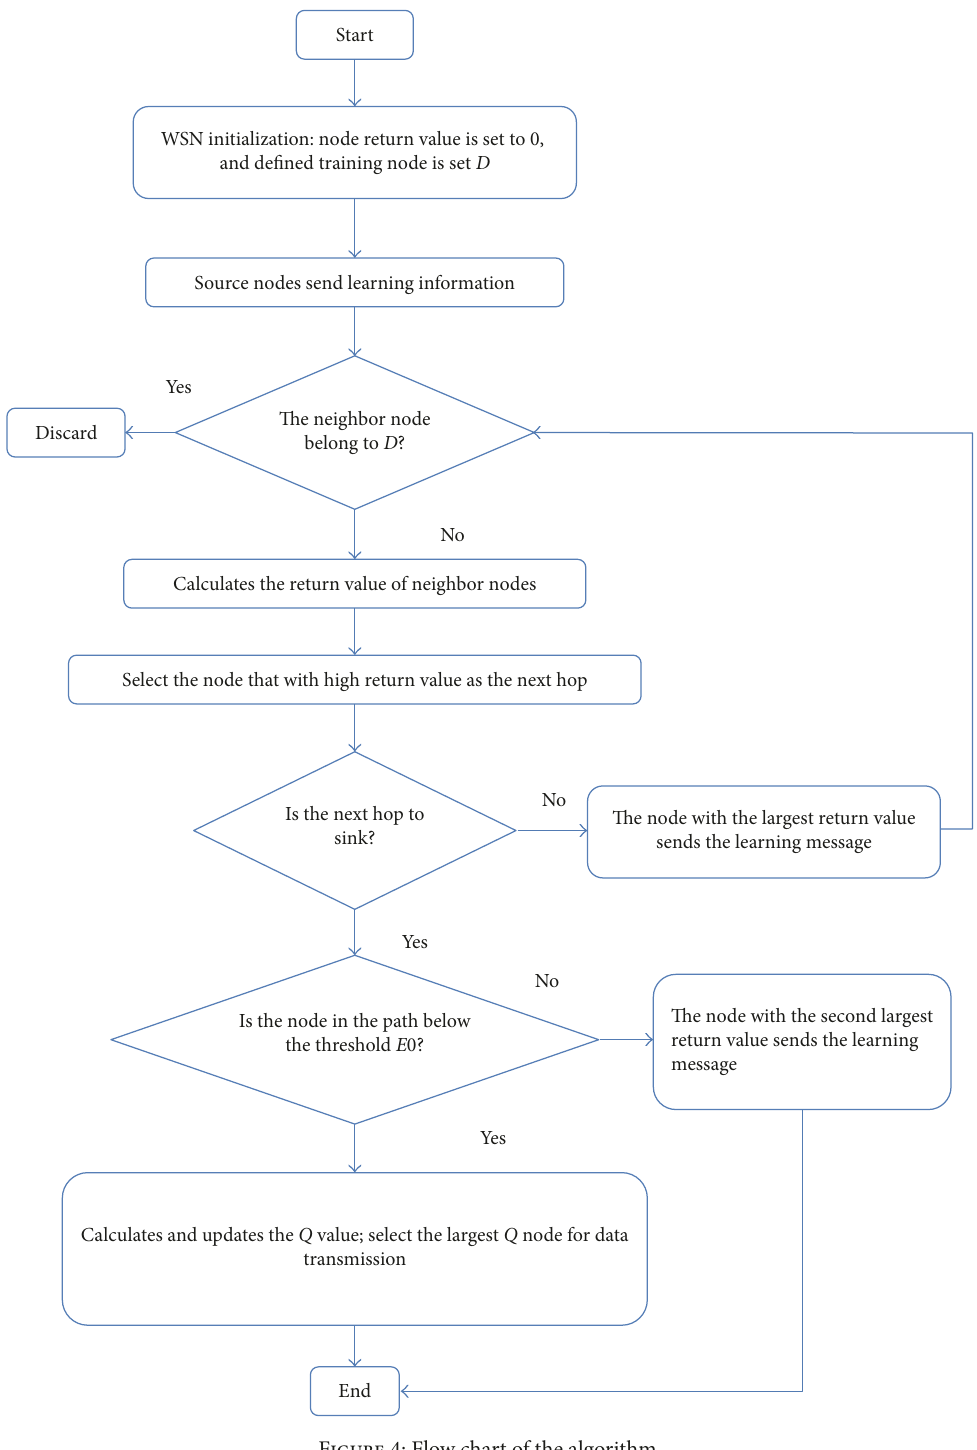
Figure 4: Flow chart of the